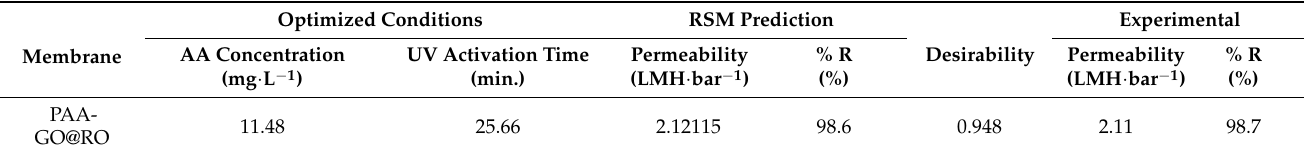
Figure 6. ( a ) Contour plot and ( b ) 3D surface model for the predicted optimized response. Table 8. Predicted and experimental responses at optimum